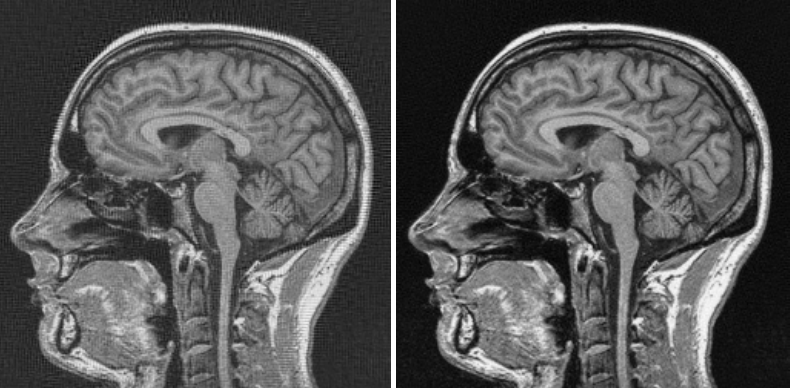
Figure 10. Left , first iteration. Right , second iteration of deconvolution using 64 + 64 discrete impulse responses on a 256 2 image.